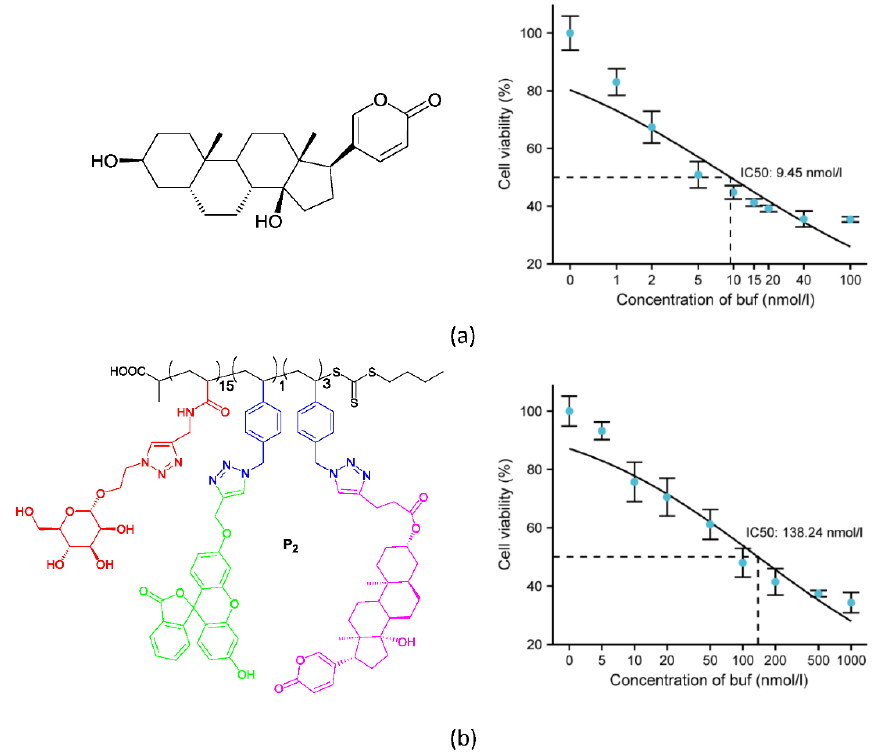
Figure 5. HepG2 cell viability against ( a ) free bufalin and ( b ) the polymer–bufalin conjugate P2 at different concentration of buf (CCK-8 assay, 48 h).